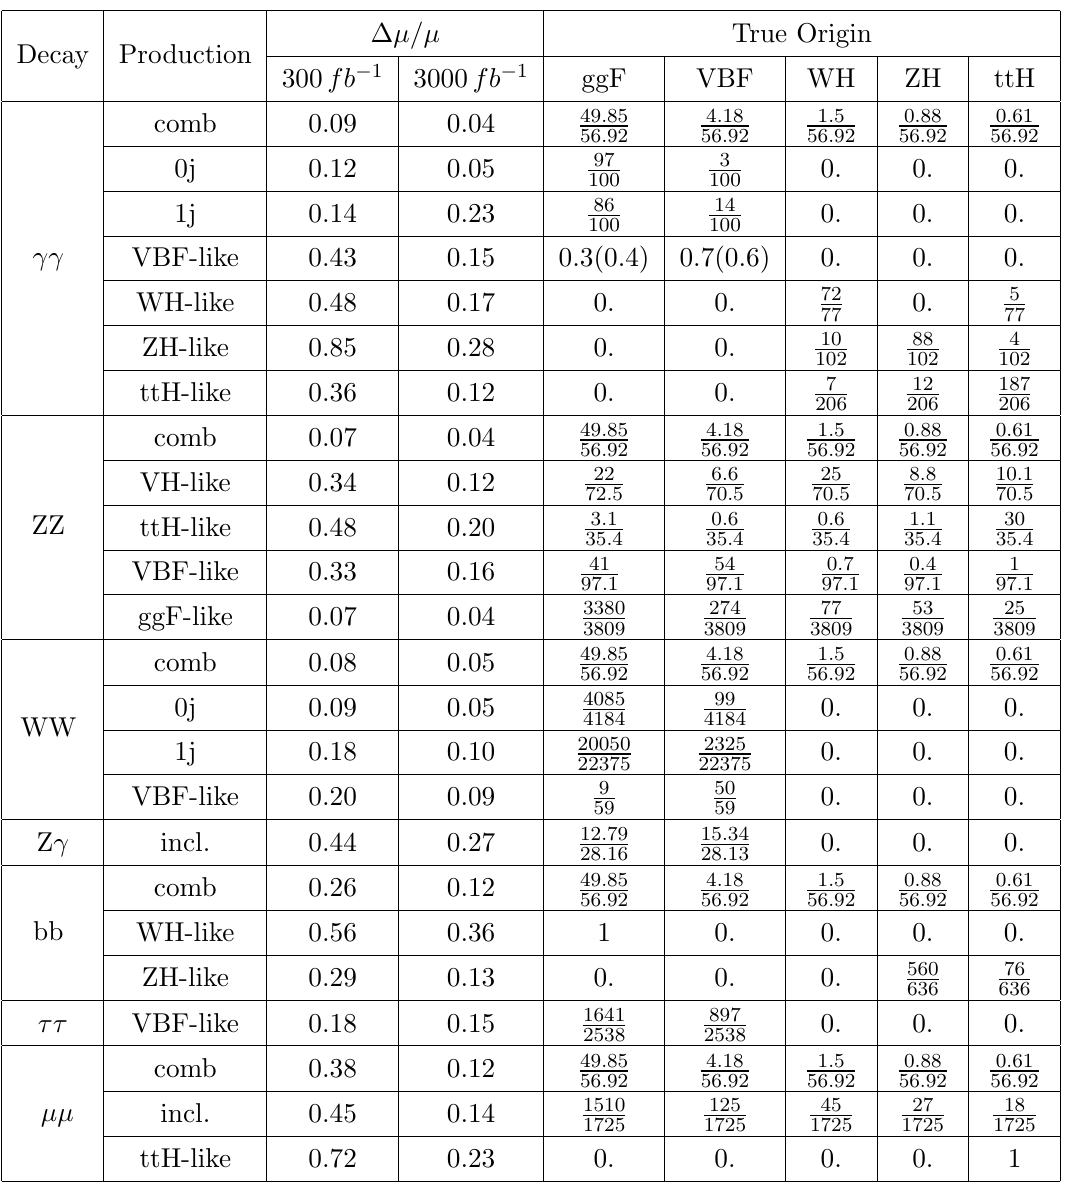
Table 9 . The normalized Higgs signal strength uncertainty [56] and their corresponding produc- tion contamination information in various channels [100{106] measured at the LHC 300 fb (cid:0) 1 and 3000 fb (cid:0) 1 . Here the contamination information are for 3000 fb (cid:0) 1 , and almost the same for 300 fb (cid:0) 1 except for the VBF-like H ! (cid:13)(cid:13) process, which are shown in brackets.